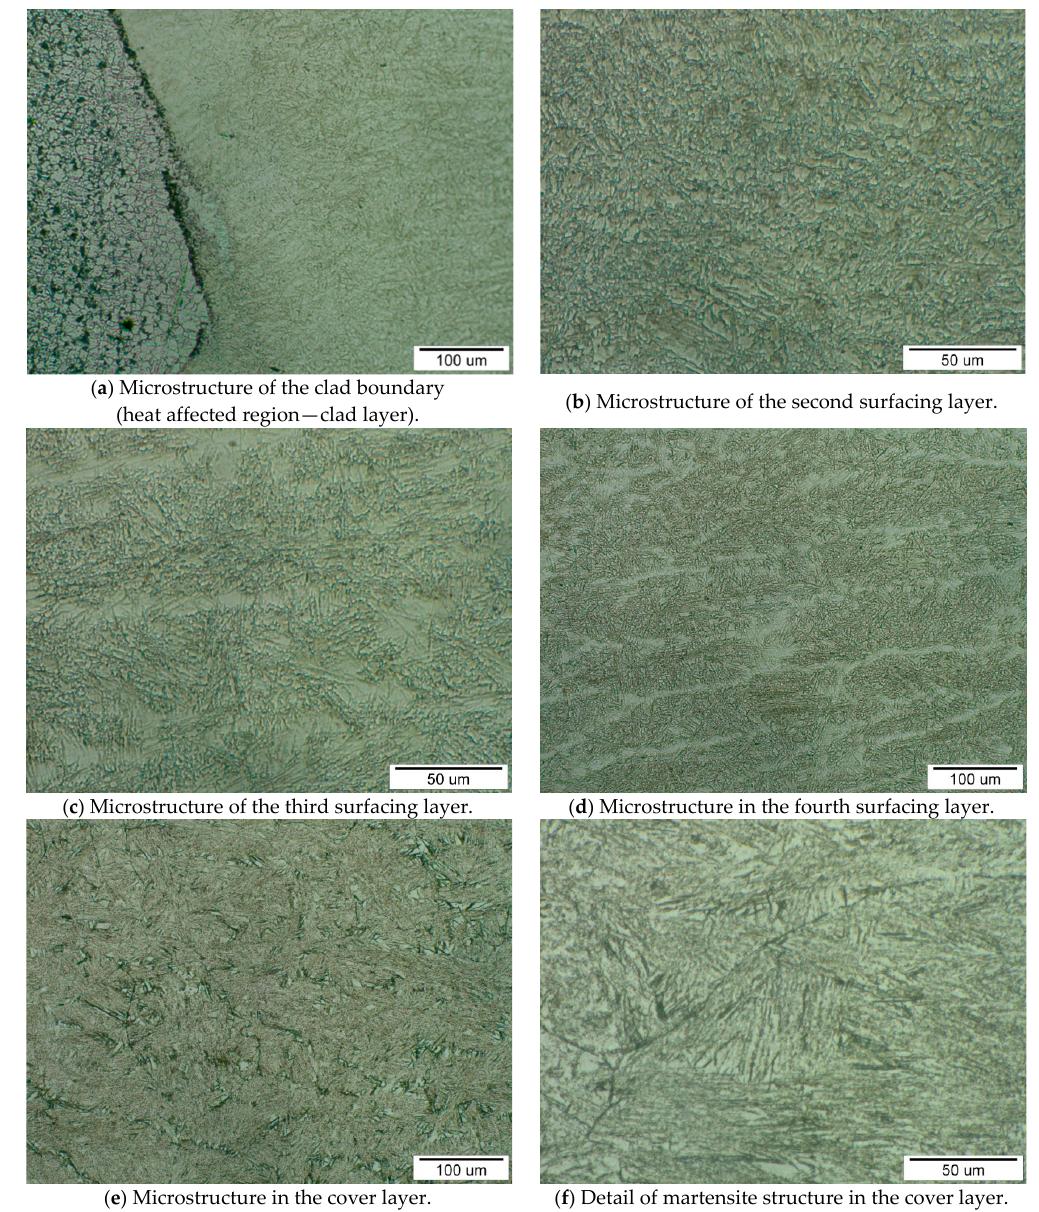
Figure 2. Microstructure of surfacing layer B1.